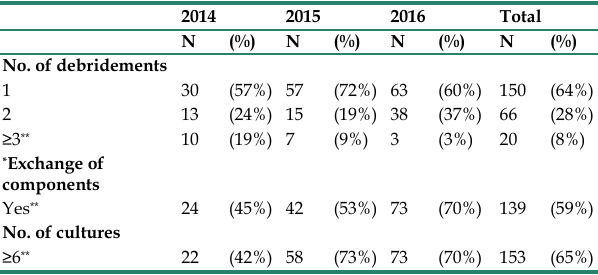
Table 3. Adherence to the regional protocol.